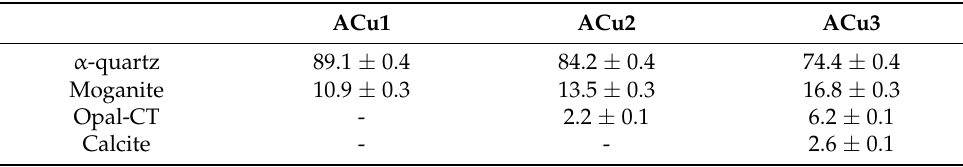
Table 1. The mineral composition (wt%) of agate samples from El Picado (Cuba) determined by X-ray diffraction measurements with Rietveld refinement.